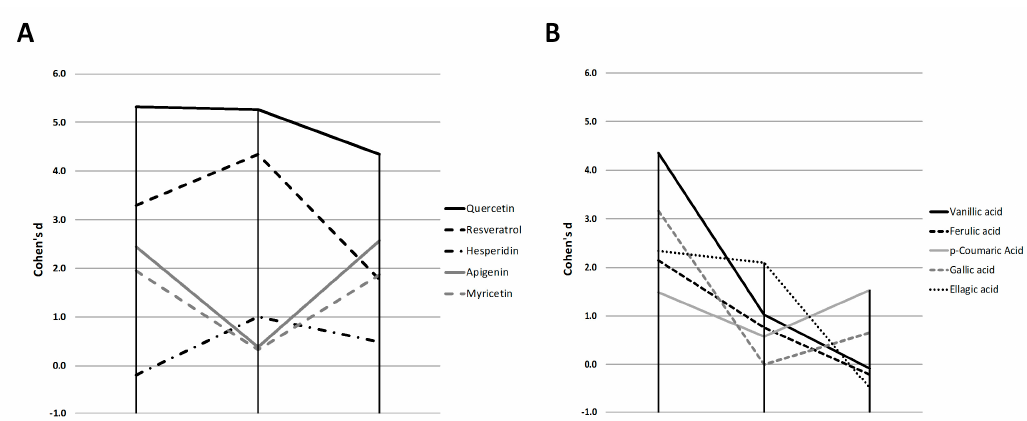
Figure 3. Representation of the Cohen’s D effect size for the anti-adipogenic activity of the different polyphenols ( A ) and phenolic acids ( B ) during the three evaluated stages (S1, S2 and S3). Those compounds with an observed toxicity at doses of 50 µM or lower were excluded.